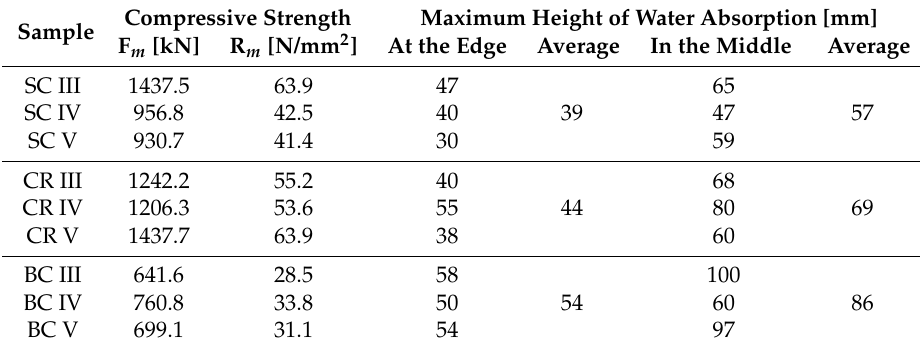
Table 3. Results of watertightness tests.